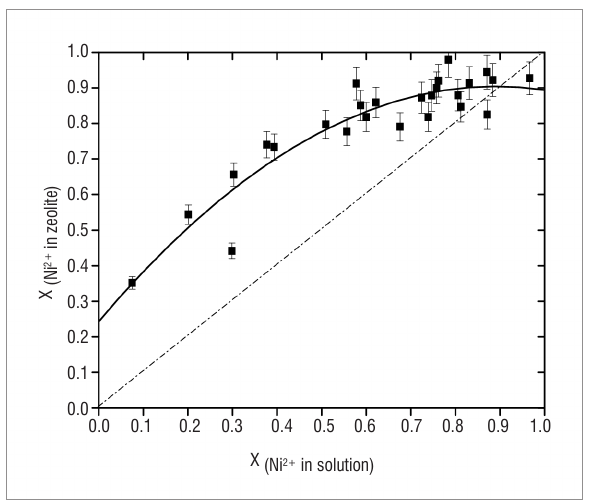
Figure 2: The K + -Ni 2+ isotherm at 298.15 K. X (Ni2+ in soln) : equivalent fraction of ingoing nickel in the liquid phase. X (Ni2+ in Zeo) : equivalent fraction of ingoing cation in the solid phase. Percentage error bars for all points are indicated. The curve was fitted to the isotherm data using a polynomial of order 2.